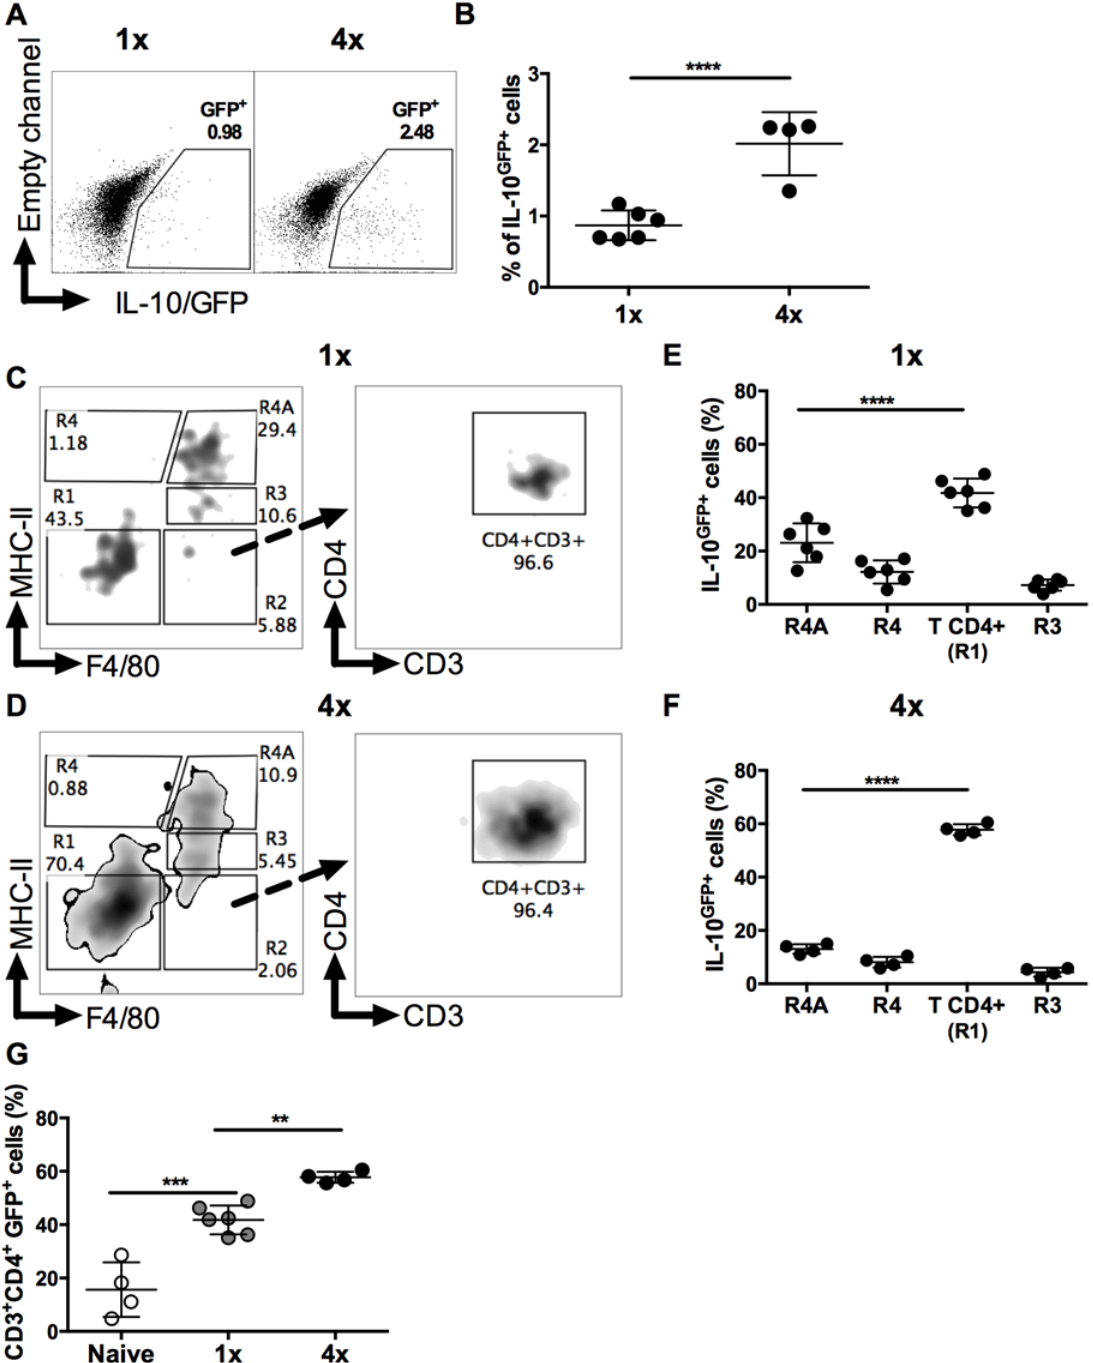
Fig 2. CD4 + T cells are the predominant source of IL-10 in DEC. ( A ) Representative flow cytometry dot plots, and ( B ) percentages ± SEM (n = 4 – 6 pinnae), of IL-10 GFP+ DEC from 1x and 4x infected mice; gate shows proportions IL-10 GFP+ cells. Representative flow cytometry dot plots of IL-10 GFP+ DEC from infected ( C ) 1x and ( D ) 4x IL-10 +/GFP mice on day 4 after final exposure to infectious cercariae. Density plots show initial F4/80 vs . MHC-II gating strategy (left-hand plots) to yield R1 (double negative F4/80 - MHC-II - ), R2 (F4/80 + MHC-II - ), R3 (F4/80 + MHC-II mid ), R4 (F4/80 - MHC-II high ), and R4A (F4/ 80 + MHC-II high ) cell populations. R1 was then gated according to CD4 vs . CD3 expression (right-hand plot). Proportions of IL-10 GFP+ DEC from infected ( E ) 1x and ( F ) 4x mice. ( G ) Proportion of IL-10 GFP+ CD3 + CD4 + T cells of total IL-10 GFP+ cells in DEC from na ï ve, 1x or 4x infected mice on day 4 post-final infection. Symbols are values for cells obtained from independent tissue samples; horizontal bars are the means ± SEM; n = 4 – 6 pinnae. ANOVA and multiple comparisons tests (Sidak ’ s and Tukey ’ s) were performed to compare the means of selected groups ( ** = p < 0.01; *** = p < 0.001; **** = p < 0.0001; ns = p >